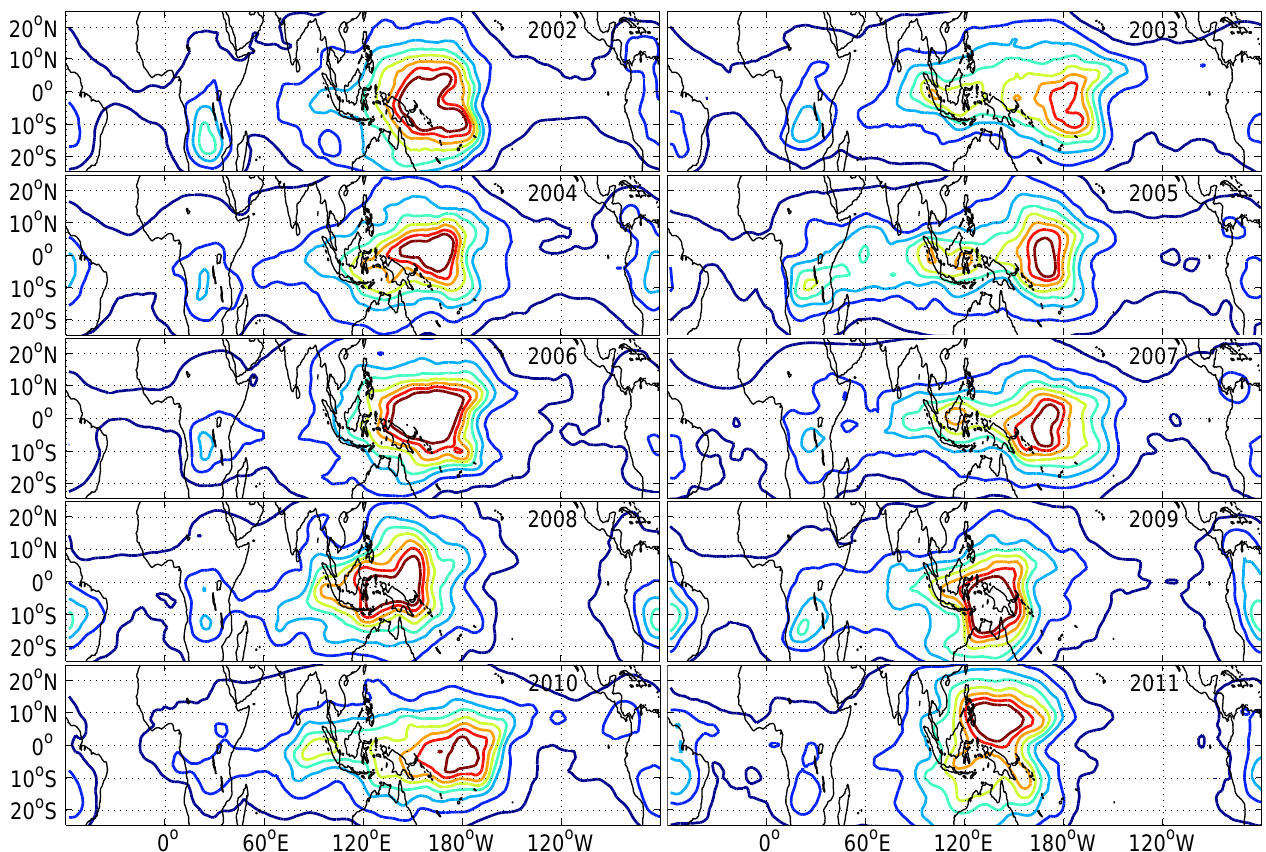
Fig. 7. Density distribution function of the horizontal positions of the trajectories between the boundary layer and the LCPs for all years from 2002–2011. The values are normalized such that a horizontally uniform distribution corresponds to a value of 1 at every grid point. Contours as in Fig.